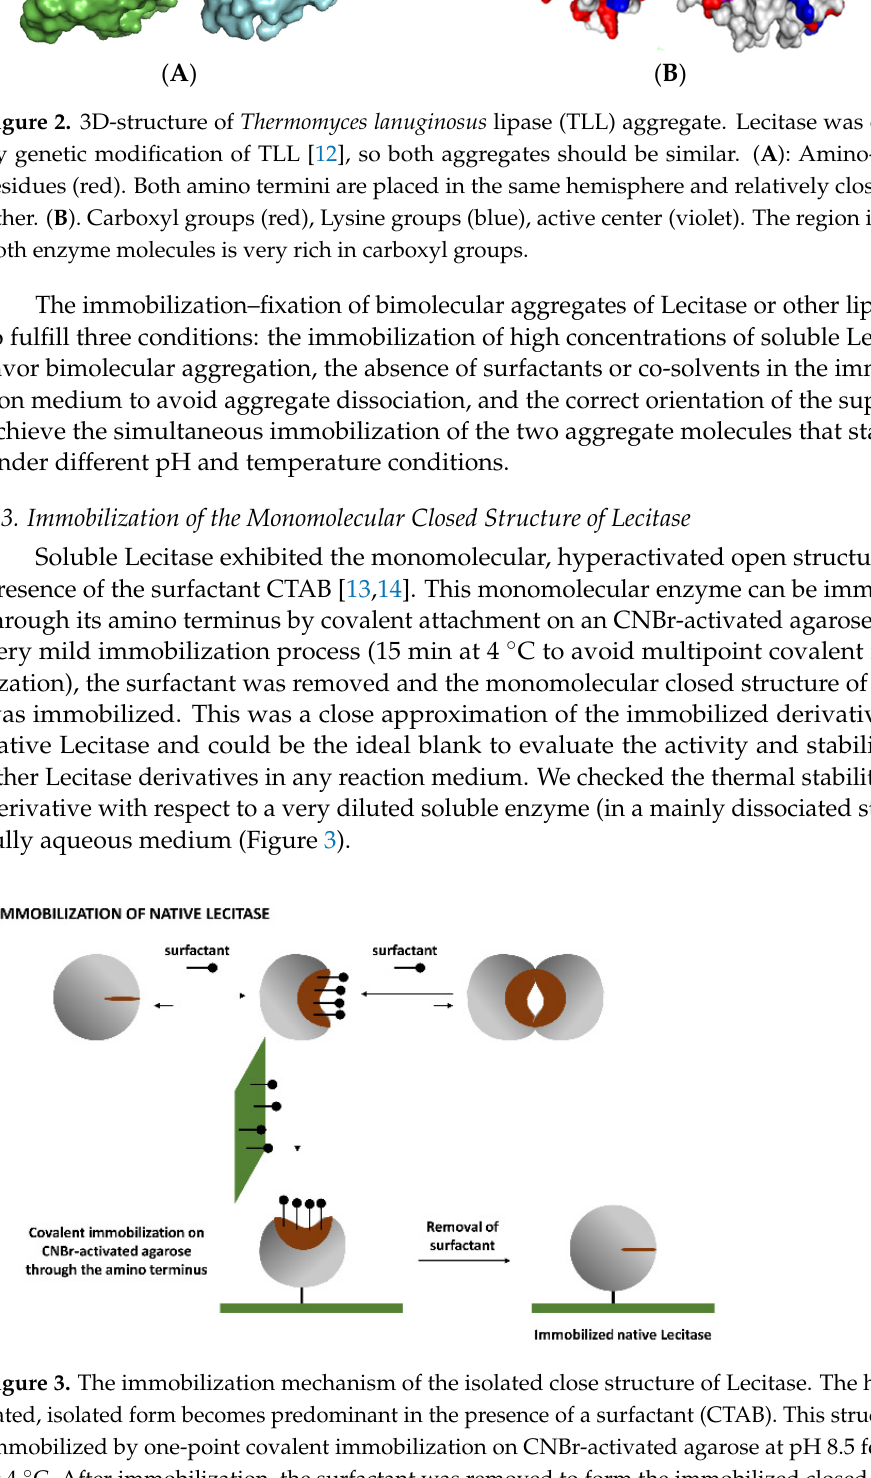
Figure 3. The immobilization mechanism of the isolated close structure of Lecitase. The hyperacti- vated, isolated form becomes predominant in the presence of a surfactant (CTAB). This structure was immobilized by one-point covalent immobilization on CNBr-activated agarose at pH 8.5 for 15 min at 4 ◦ C. After immobilization, the surfactant was removed to form the immobilized closed structure of the enzyme.